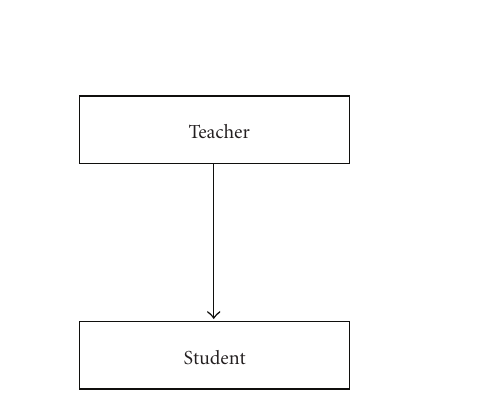
Figure 1: Teacher-student relationship in compliant self-